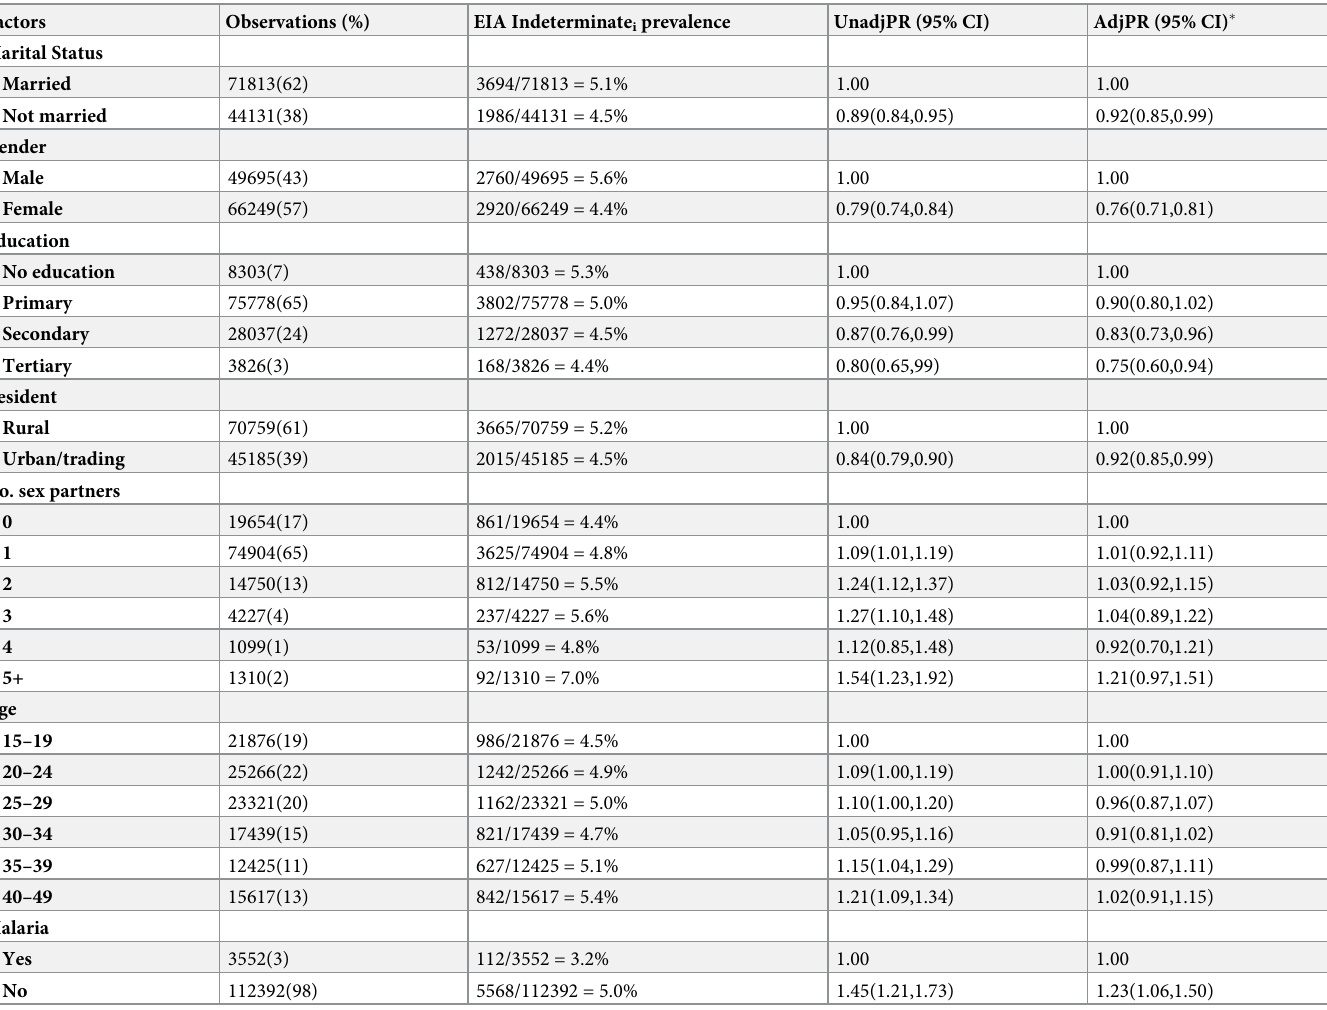
Table 1. Factors associated with HIV serologically indeterminate results among 39440 (115944 person-visits) RCCS participants in Rakai, Uganda